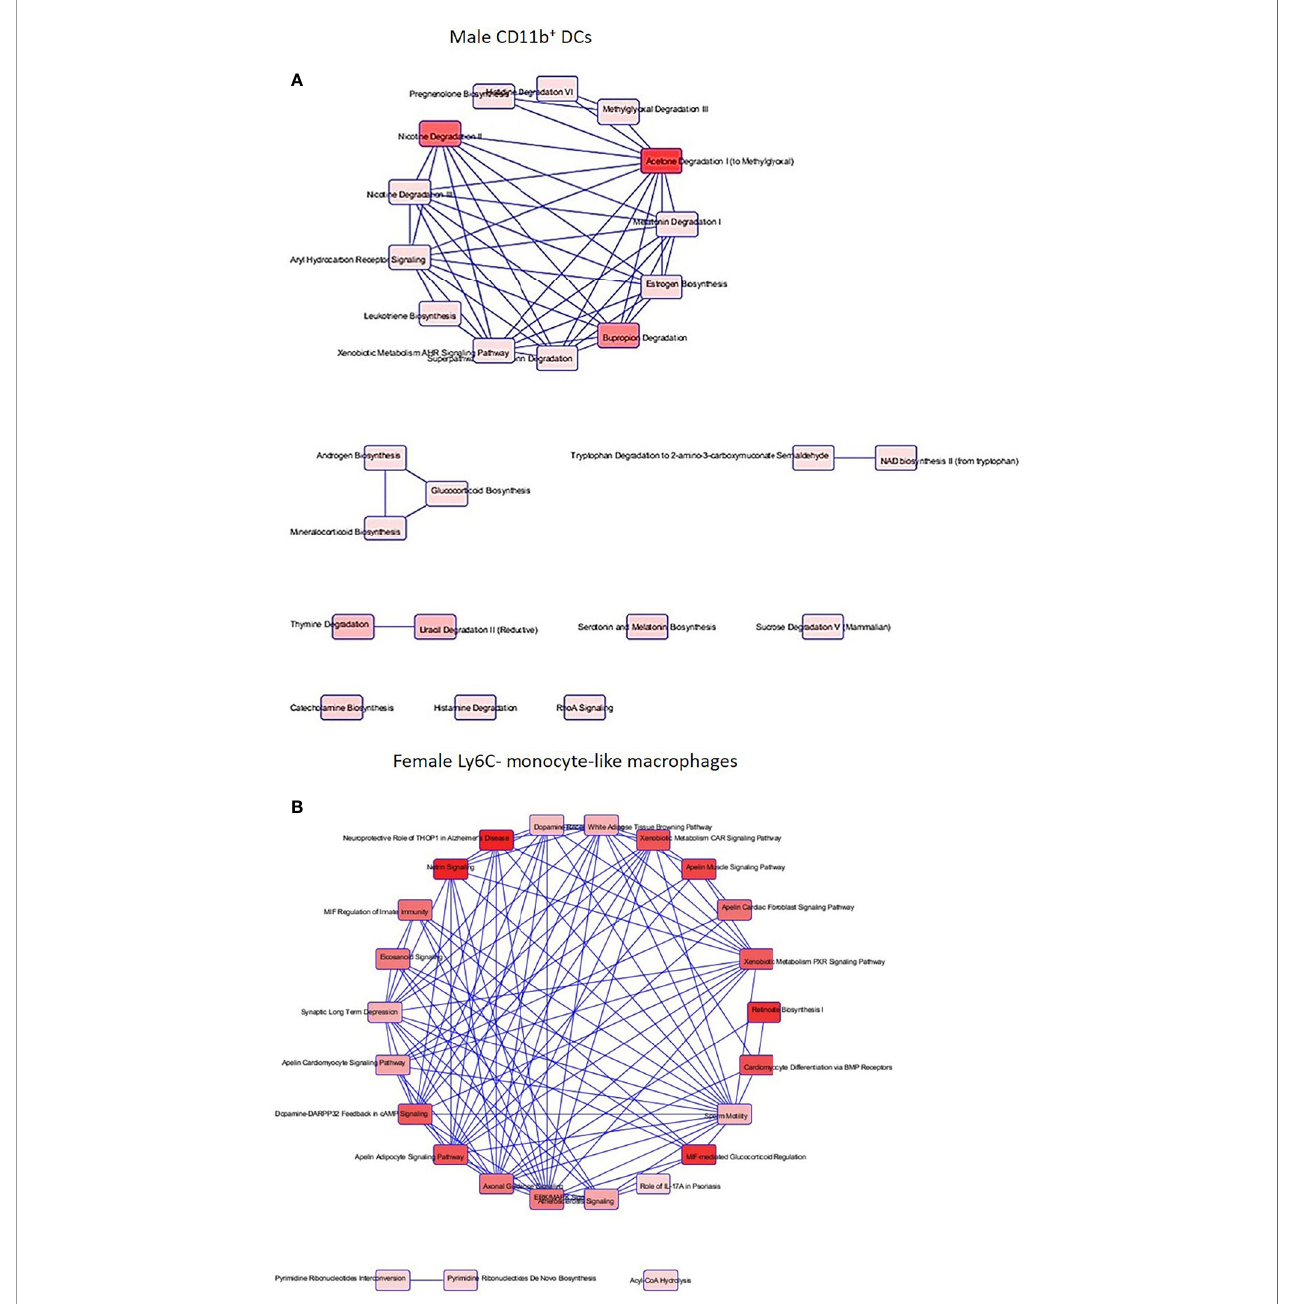
FIGURE 7 | C. neoformans leads to a highly differentiated network of associated metabolic pathways within permissive phagocytes and fungicidal (non-permissive) phagocytes. Using male and female BALB/c mice, phagocyte subsets were puri fi ed and incubated with C. neoformans strain H99 at 37°C, 5% CO 2 for 2hrs at a ratio of 20:1. Following incubation, cells were collected and stored in TRIzol at -20°C until analysis. RNA puri fi cation and analysis was conducted by Novogene using SMARTer Stranded V2 library prep and samples were sequenced using the Illumina Platform. Differential expression analysis was compared between each macrophage and DC subset alone and when incubated with C. neoformans strain H99. Signi fi cant differences within gene expression were identi fi ed and grouped into predicted canonical (active) pathways using Ingenuity Pathway Analysis (IPA) software. (A) Associated pathways containing overlapping genes when comparing male CD11b + DCs interacting with C. neoformans to CD11b + DCs alone. (B) Associated pathways containing overlapping genes when comparing female Ly6c - monocyte-like macrophages interacting with C. neoformans to Ly6c - monocyte-like macrophages alone. Connecting lines indicate pathways with shared genes. Boxes shaded from dark red to light red indicates a difference p < 0.05 from greatest to least, respectively. Data were generated from 2 independent female and 2 independent male mouse experiments (n=2 male and female